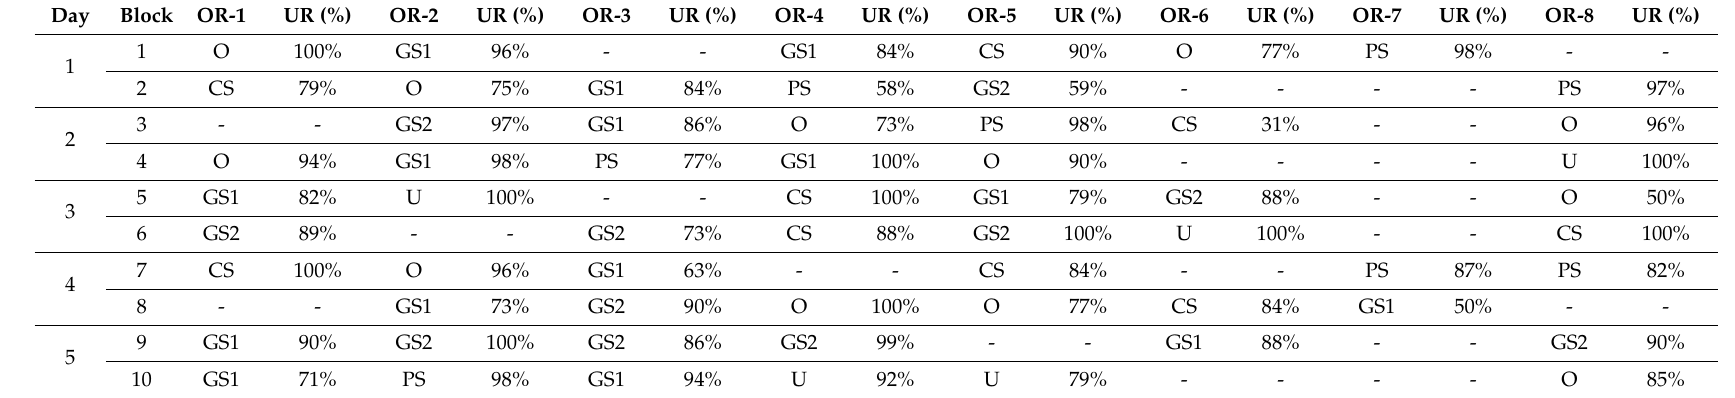
Table 2. Created schedule for Scenario 1 as a result of the goal programming